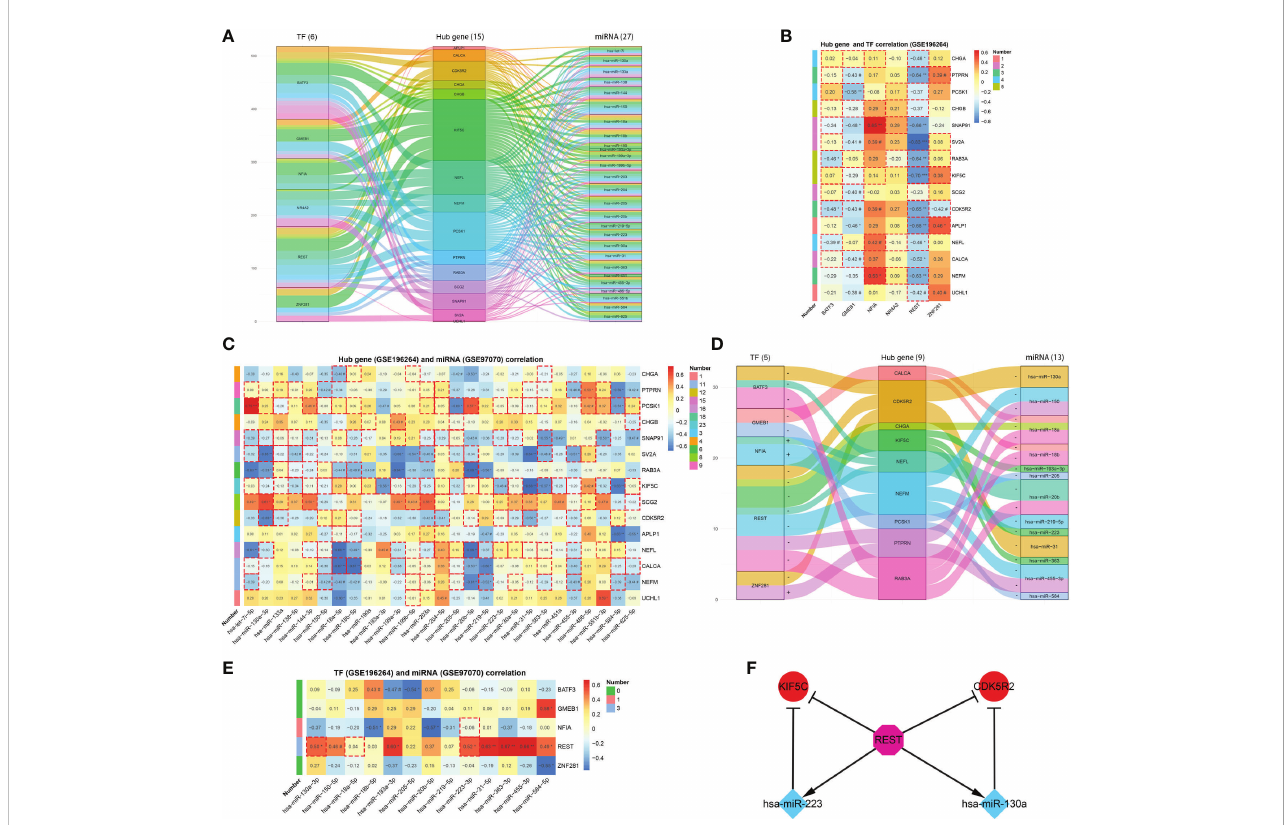
FIGURE 5 TF-mRNA-miRNA network for MTC. (A) Predicted TF-mRNA-miRNA network. (B) Heatmap of hub gene and TF correlation. (C) Heatmap of hub gene and miRNA correlation. (D) Validated TF-mRNA-miRNA network. (E) Heatmap of TF and miRNA correlation. (F) Constructed feed-forward loops based on the TF-mRNA-miRNA network. Data in the heatmap rectangle indicates correlation coef fi cient, of which those with dotted rectangle borders being predicted pairs. Number in the heatmap indicates pairs with dotted rectangle borders each row. #, p < 0.1; *p < 0.05; **p < 0.01; ***p <